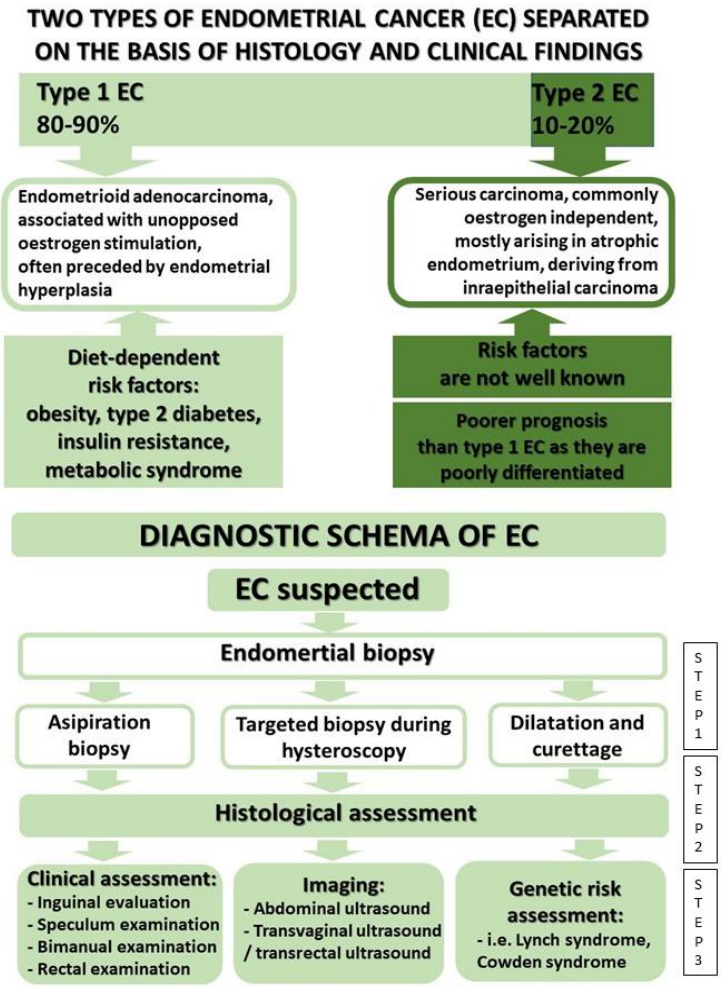
Figure 1. Types of EC and diagnosis schema. Type 1 cancer, diagnosed in 80% of the cases, is described as endometroid and includes cases of highly and intermediately differentiated cancer (G1, G2) [6]. It develops from proliferation caused by the stimulation, not balanced by progesterone or other